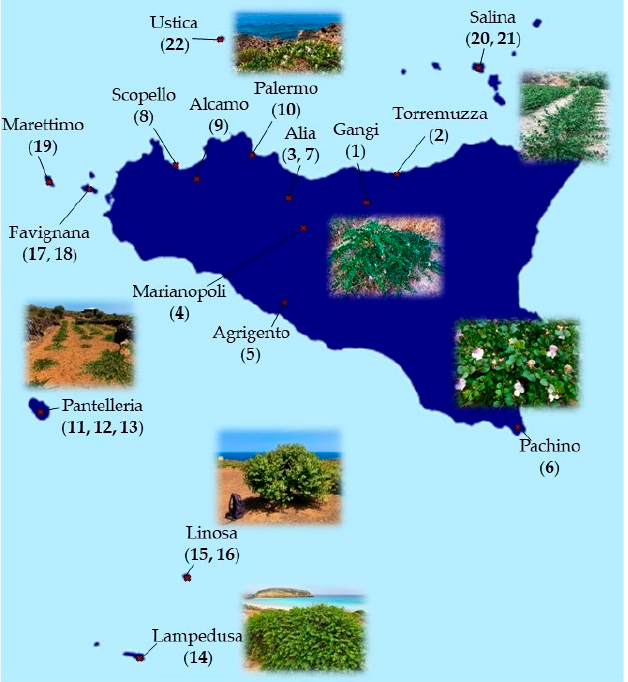
Figure 2. Geographical distribution of the different populations of Capparis collected.